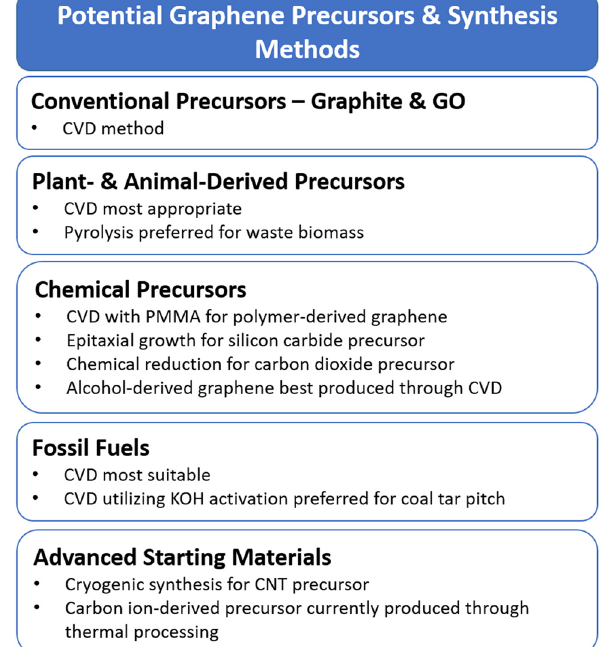
Figure 9: Summary of potential graphene precursors and synthesis